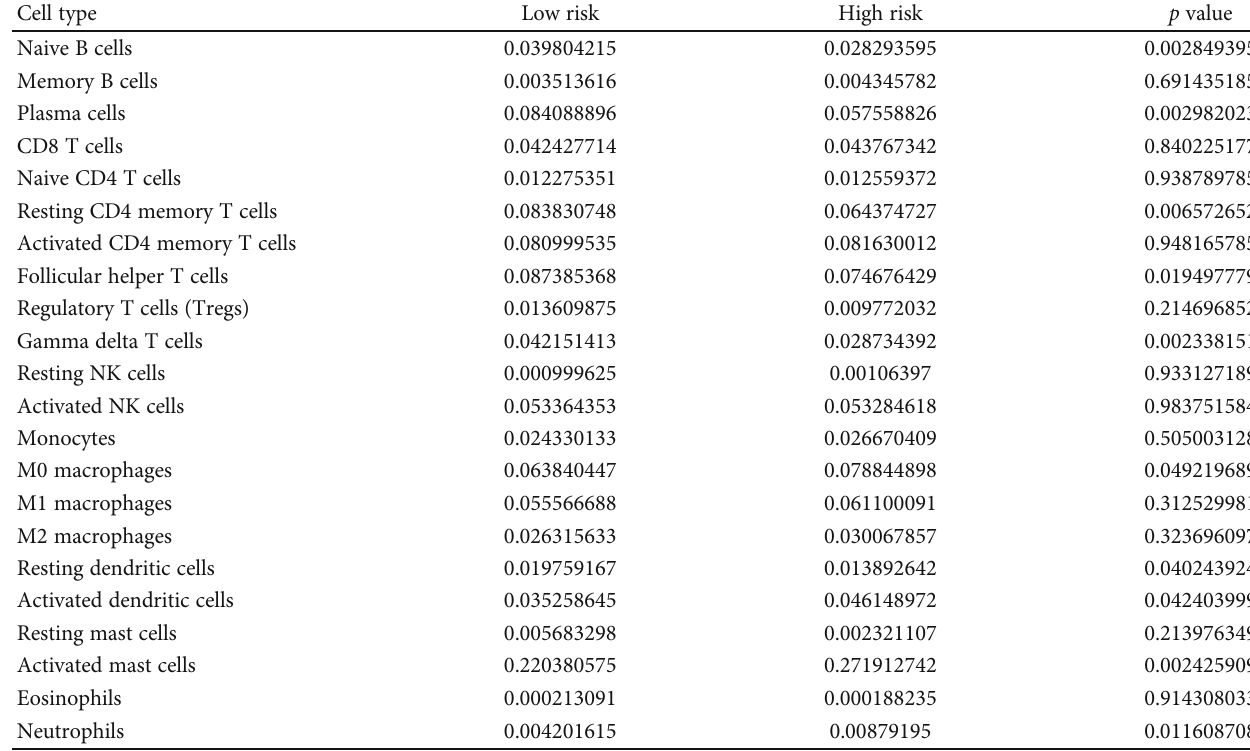
Table 3: Di ff erential immune cell type expression was observed between the high and low RS groups in the GSE65858 cohort.